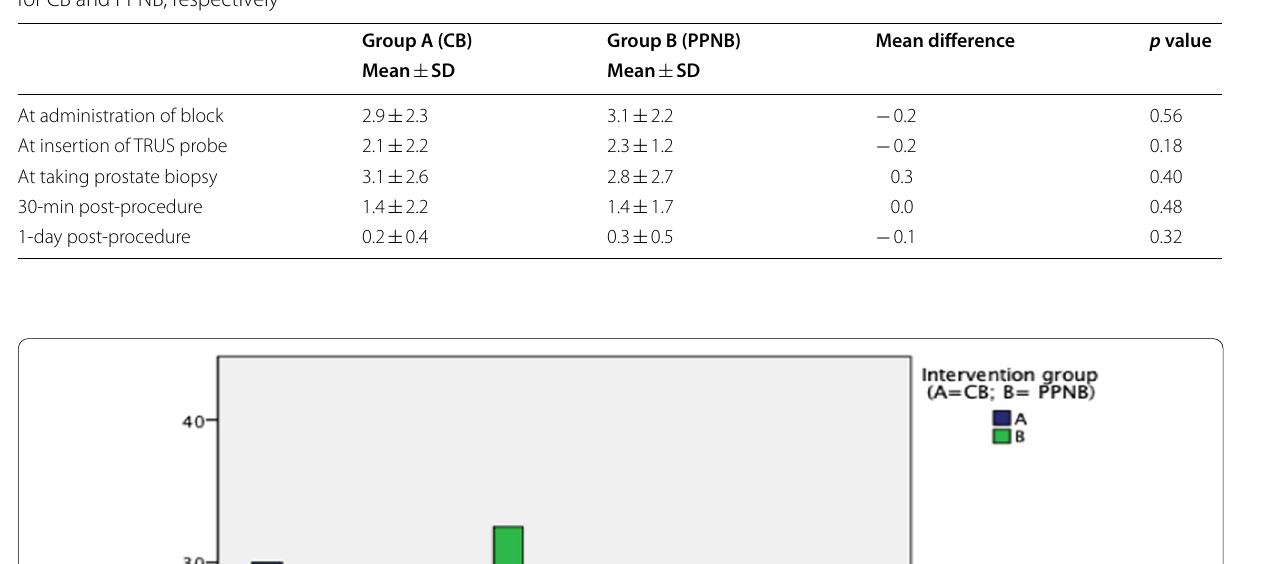
Table 2 Modal pain score at administration of block was 3 for both groups, while at insertion of probe, the modal scores were 0 and 3 for CB and PPNB, respectively